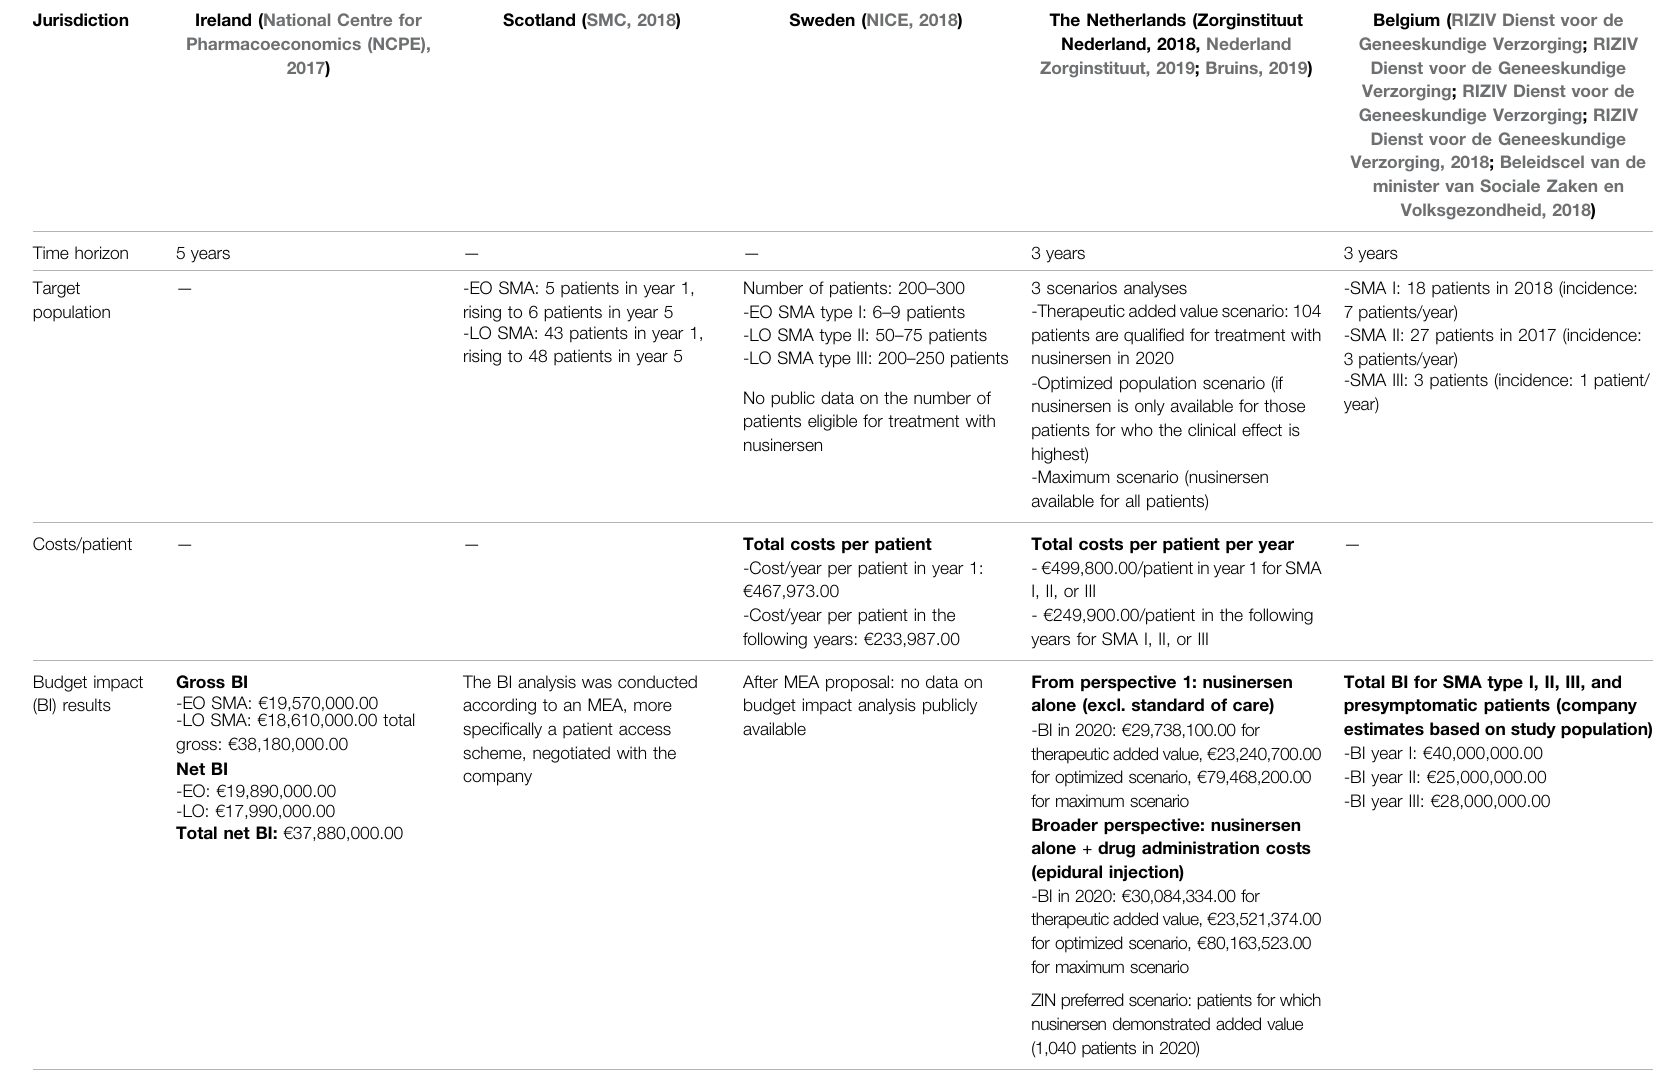
TABLE 4 | Overview of budget impact analysis of nusinersen in fi ve European countries and the US.